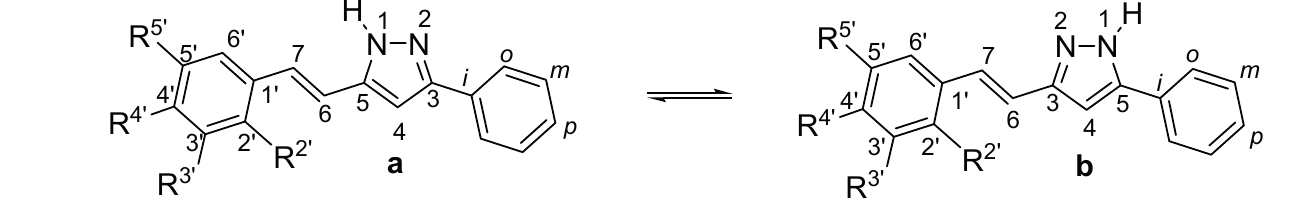
Figure 8. Atom numbering for NMR